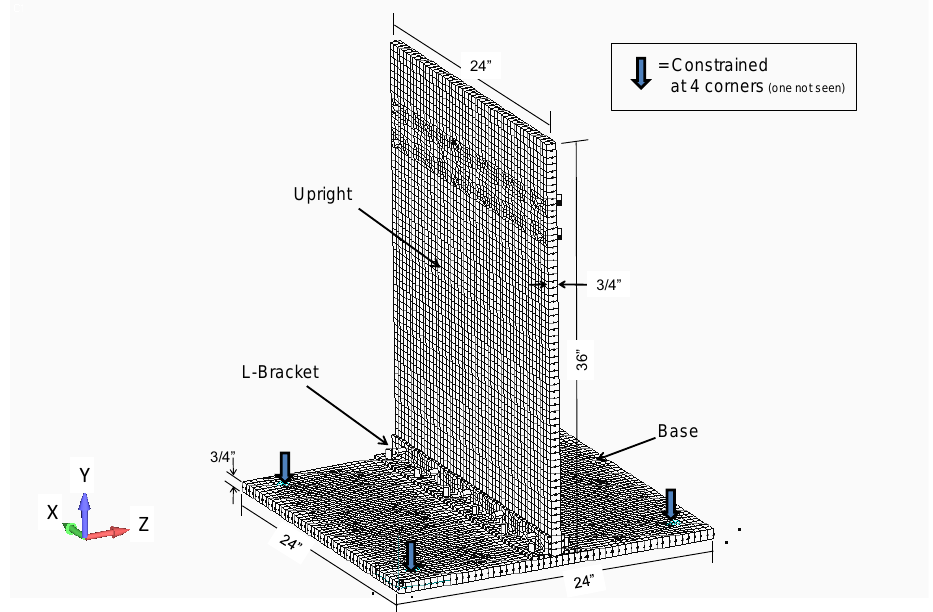
Fig. 8. Base-upright structure used for testing.